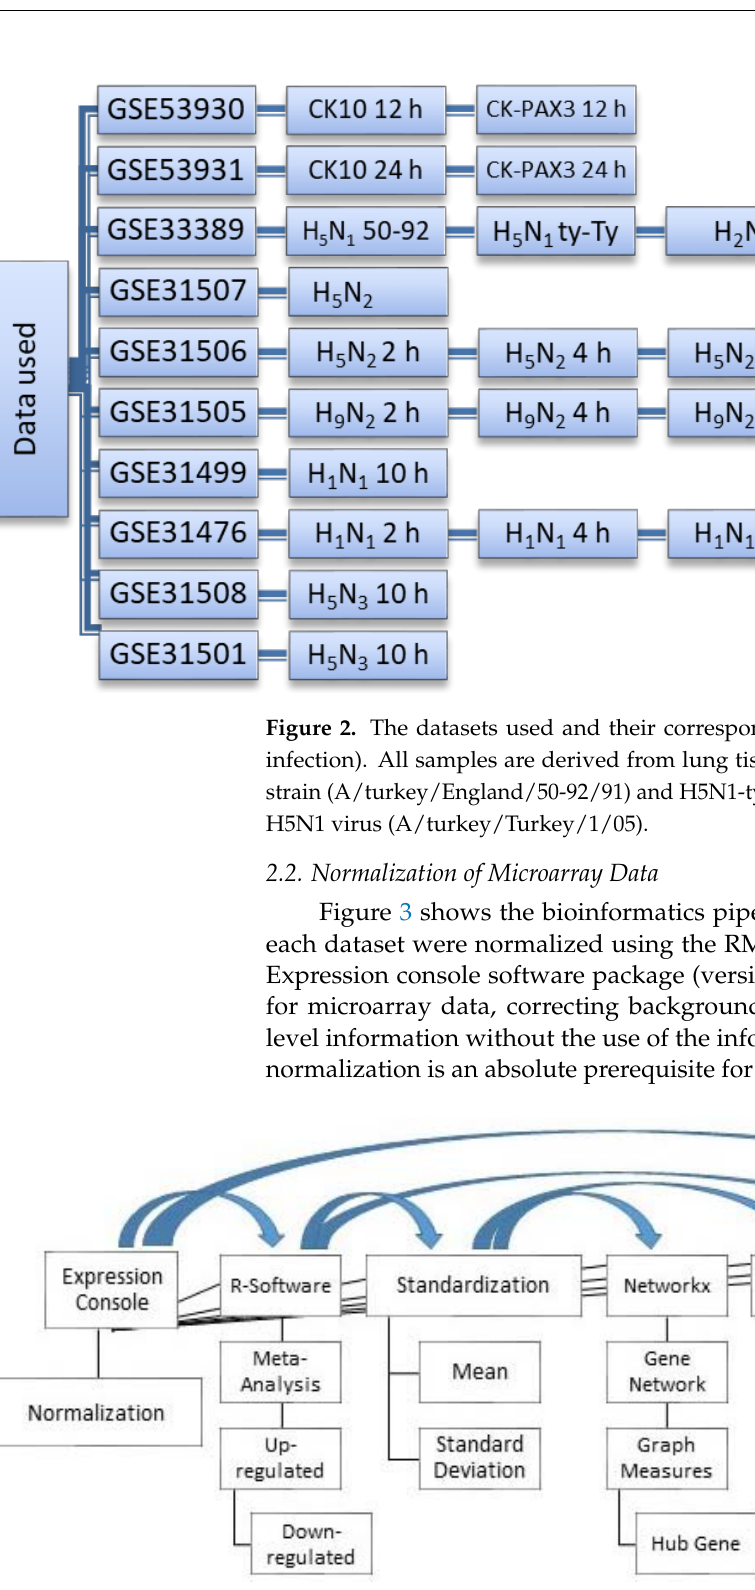
Figure 3. Analysis pipeline used in this study (Arrows indicate where results from one software were used as input for another program). MEV = multiple experiment viewer.